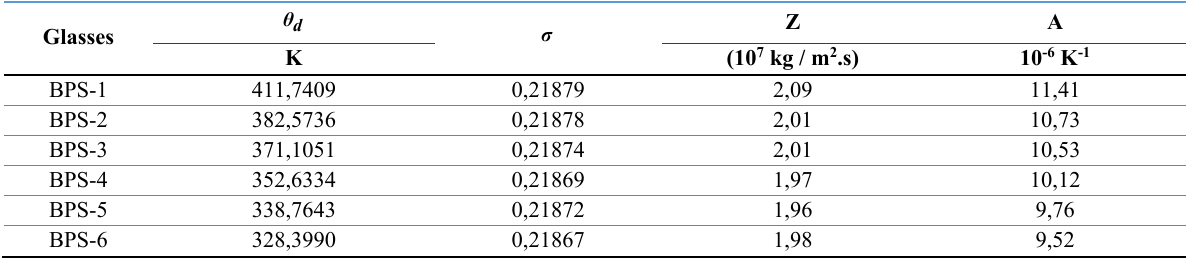
Table 3 D ebye Temperature ( ) θ d , Poisson Coefficient ( ) σ , Acoustic Impedance (Z) and Coefficient of Thermal Expansion